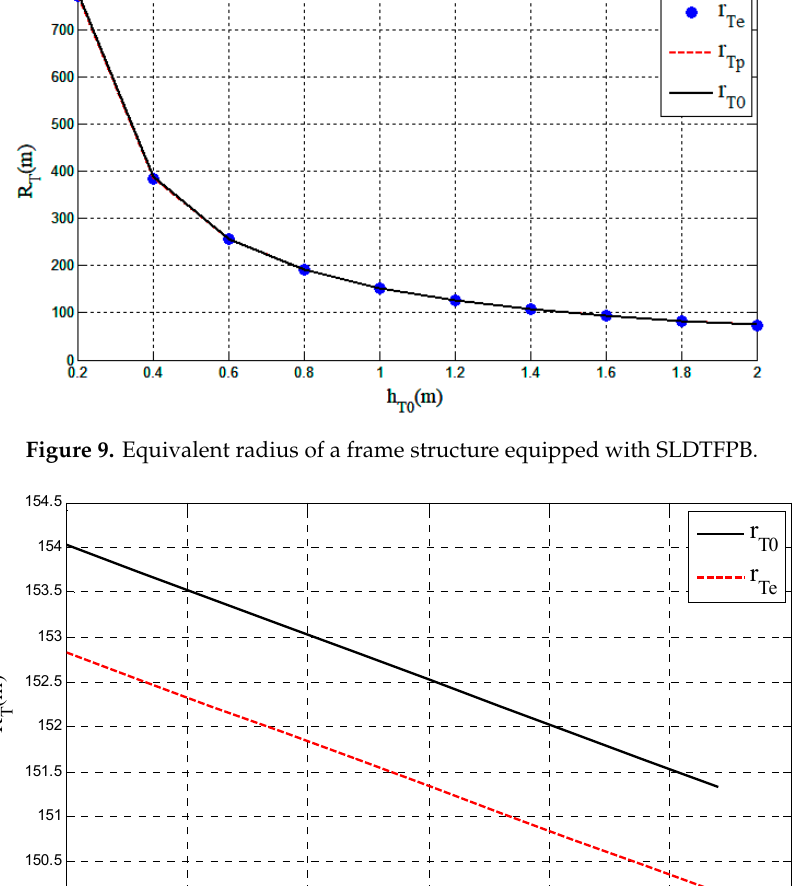
Figure 10. Equivalent radius of a frame structure equipped with SLDTFPB.